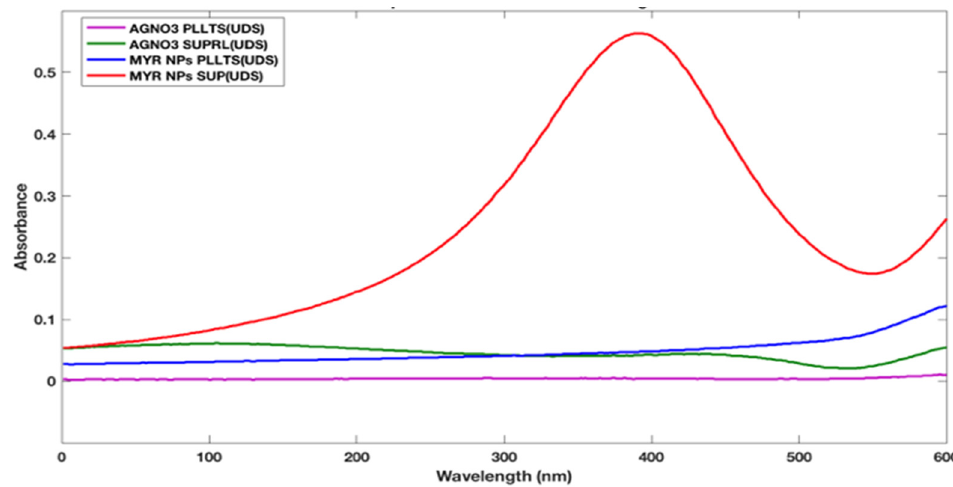
Figure 2. UV-vis spectra of Myricetin and the AgNPs.